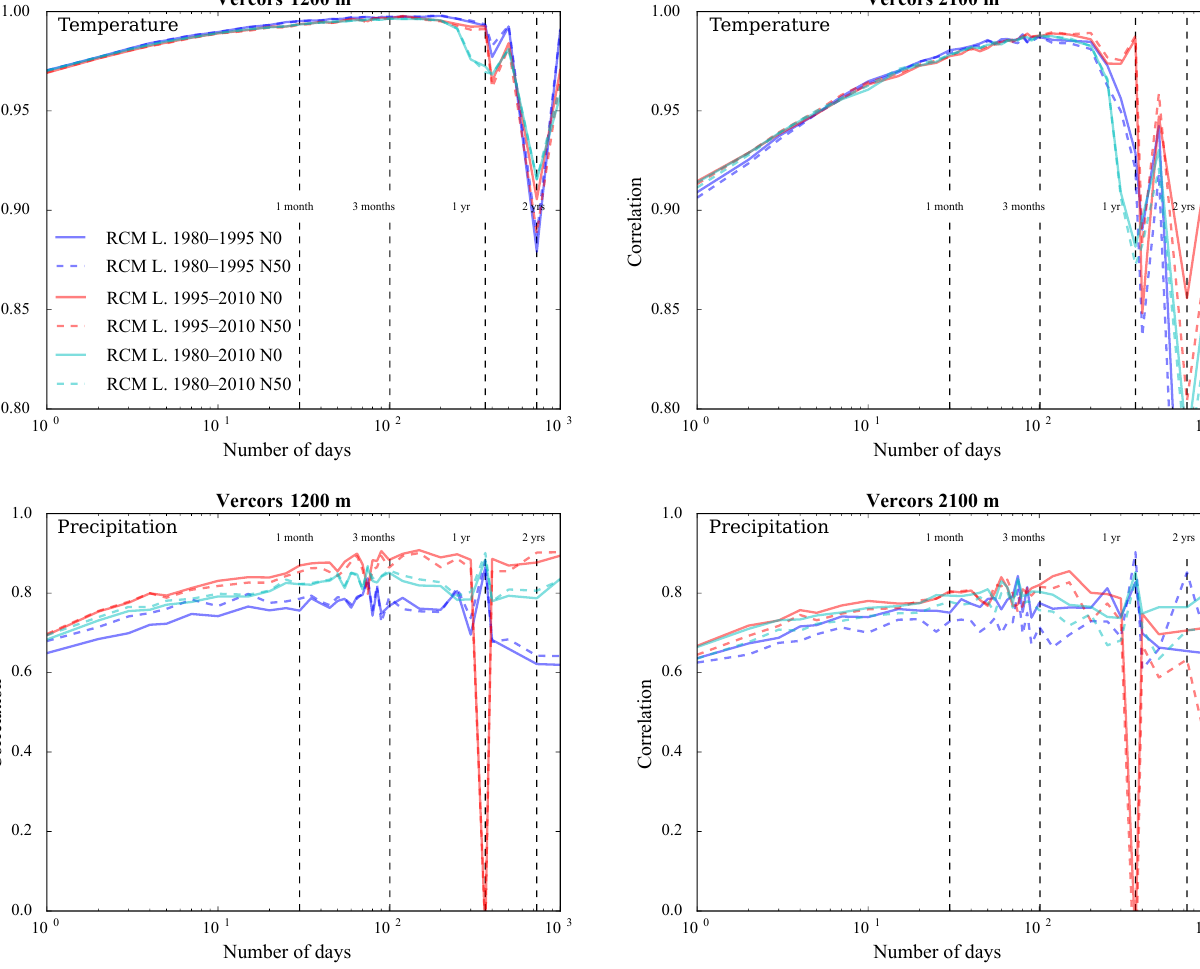
Figure 15. Correlation between the SAFRAN reanalysis and adjusted RCM temperature and precipitation as a function of the integration window over the evaluation period for the Vercors massif at 1200 and 2100ma . s . l